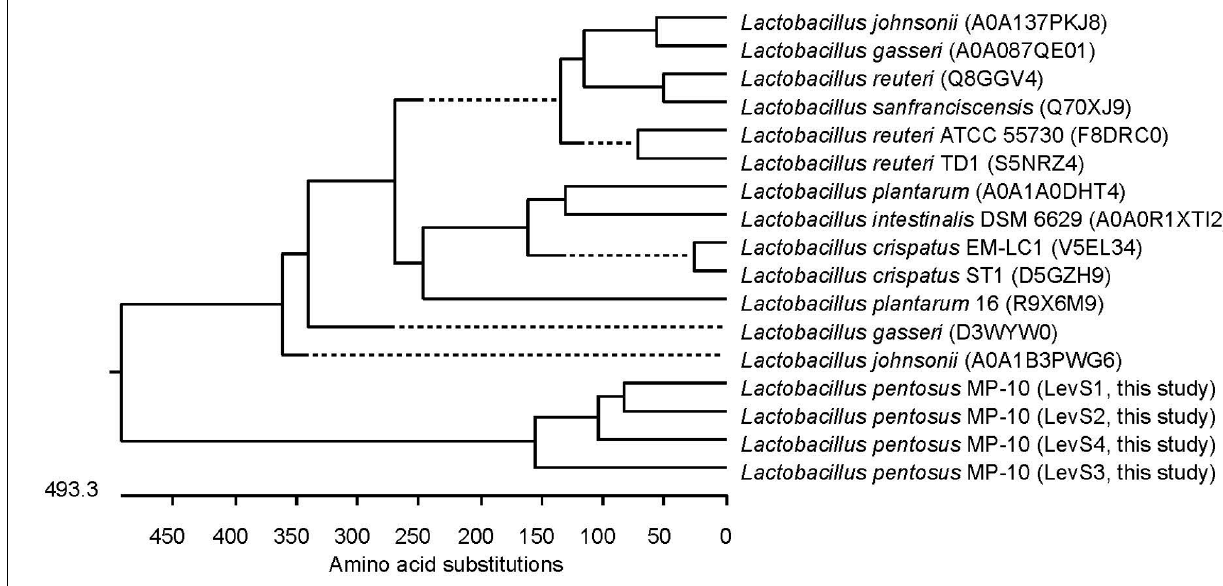
FIGURE 3 | Phylogenetic relationships of L. pentosus MP-10 and other Lactobacillus sp. inferred from the alignment of levansucrase proteins. The sequences were aligned and the most parsimonious phylogenetic trees were constructed using the CLUSTAL W of Lasergene program, version 14 (MegAlign 14, Inc., Madison, WI, USA). The scale below indicates the number of amino acid substitutions. Accession numbers are indicated in